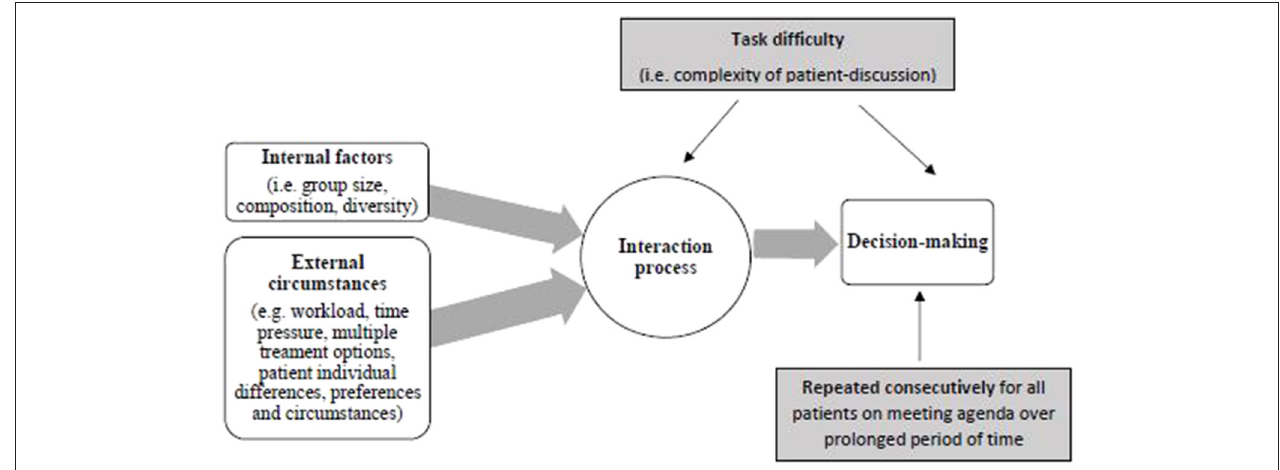
FIGURE 1 | Graphical representation of the functional perspective of group decision-making as applied to cancer multidisciplinary team meetings.